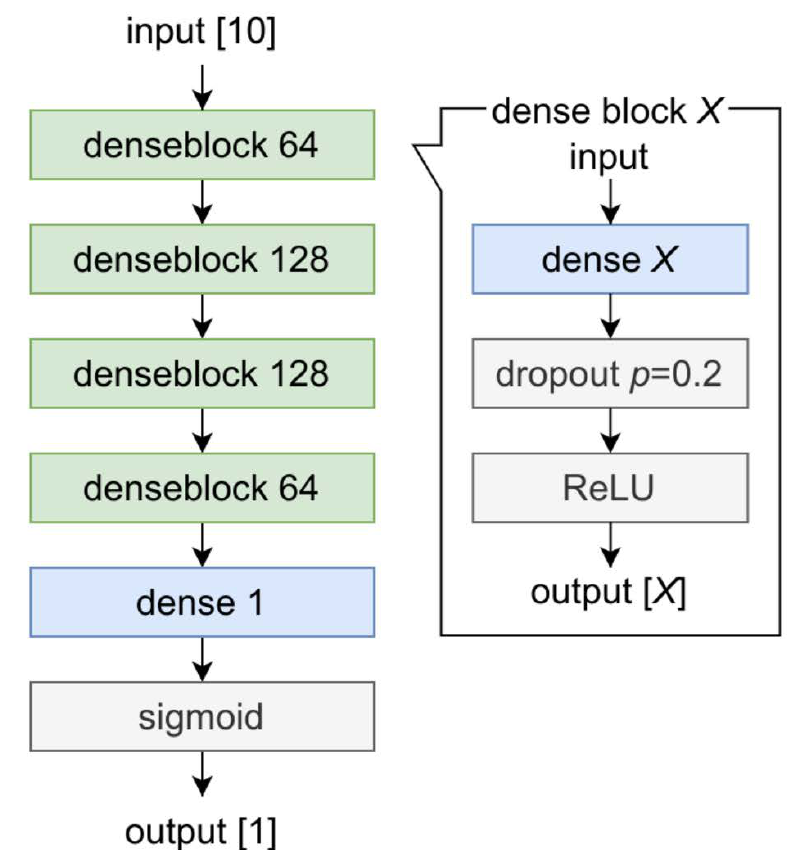
Figure 2. Structure of our artificial neural network (ANN) model. Denseblock is defined as a single block based on a combination of a dense layer, dropout layer and ReLU. The X corresponds to the dimension of the output tensor. ANN; artificial neural network: ReLU; rectified linear